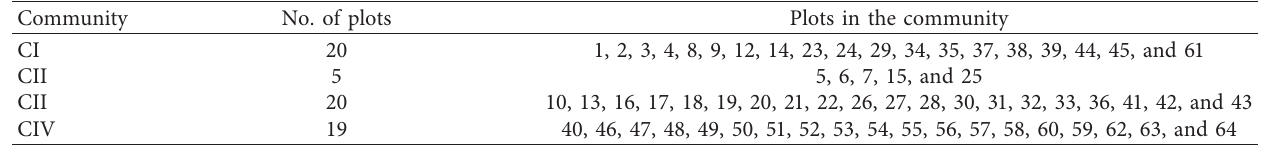
Table 3: The community types and distribution of sample plots.